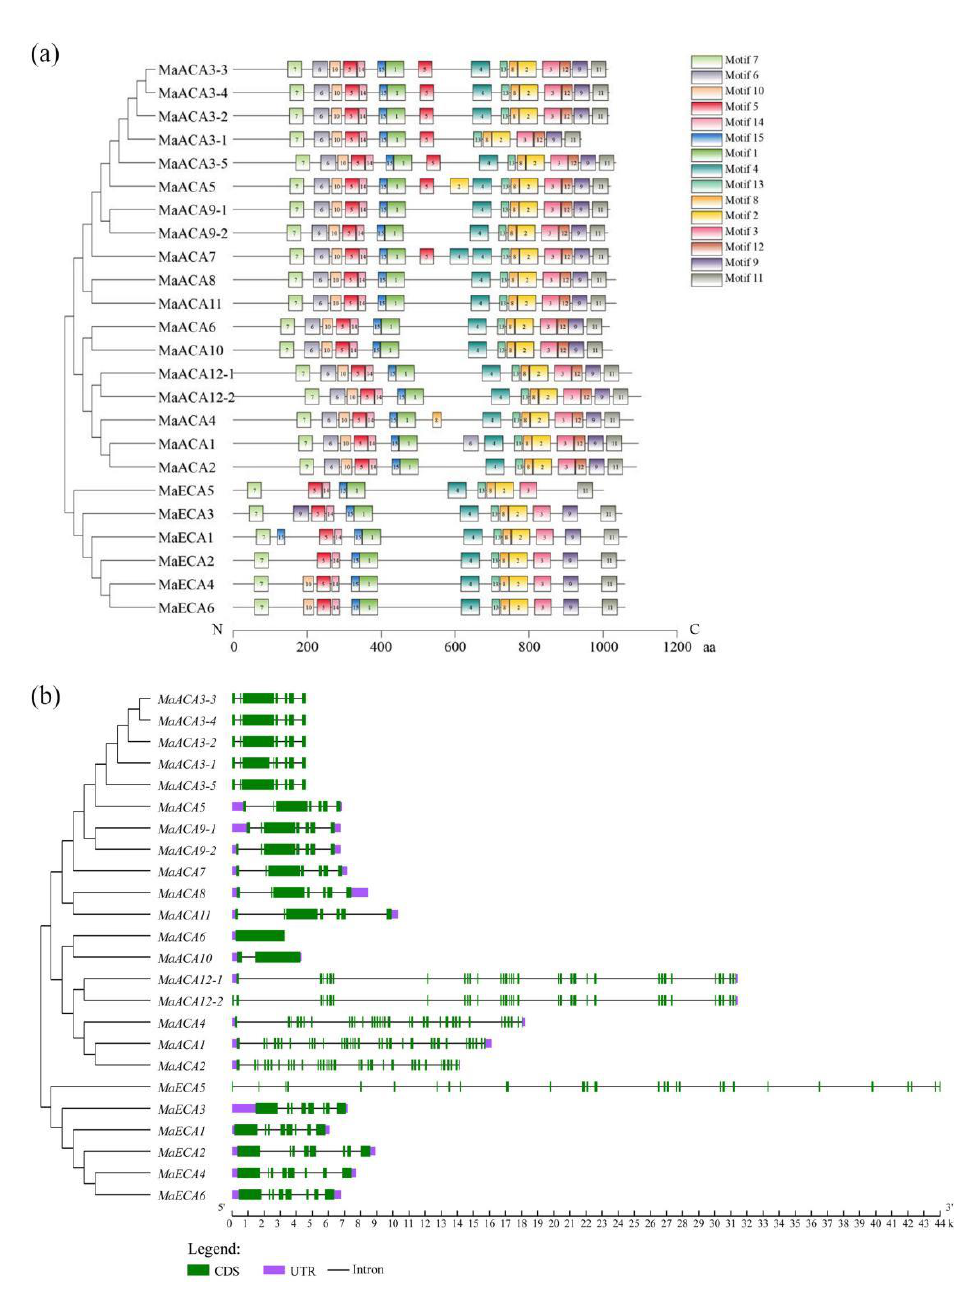
Figure 3. Motif distributions ( a ) in banana Ca 2+ -ATPase proteins and gene structures ( b ) of their corresponding genes.